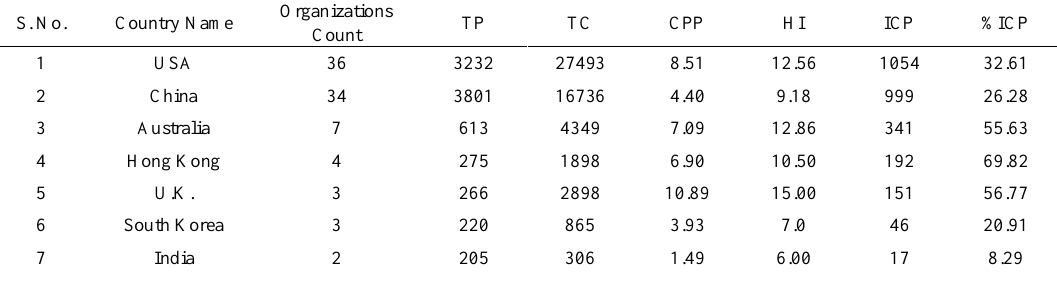
Figure 3. Top 100 Organizations in Big Data Research by Country of Origin: 2007-16. Table 5. Publication and Citation Profile of Top 100 Organizations by Country of Origin: